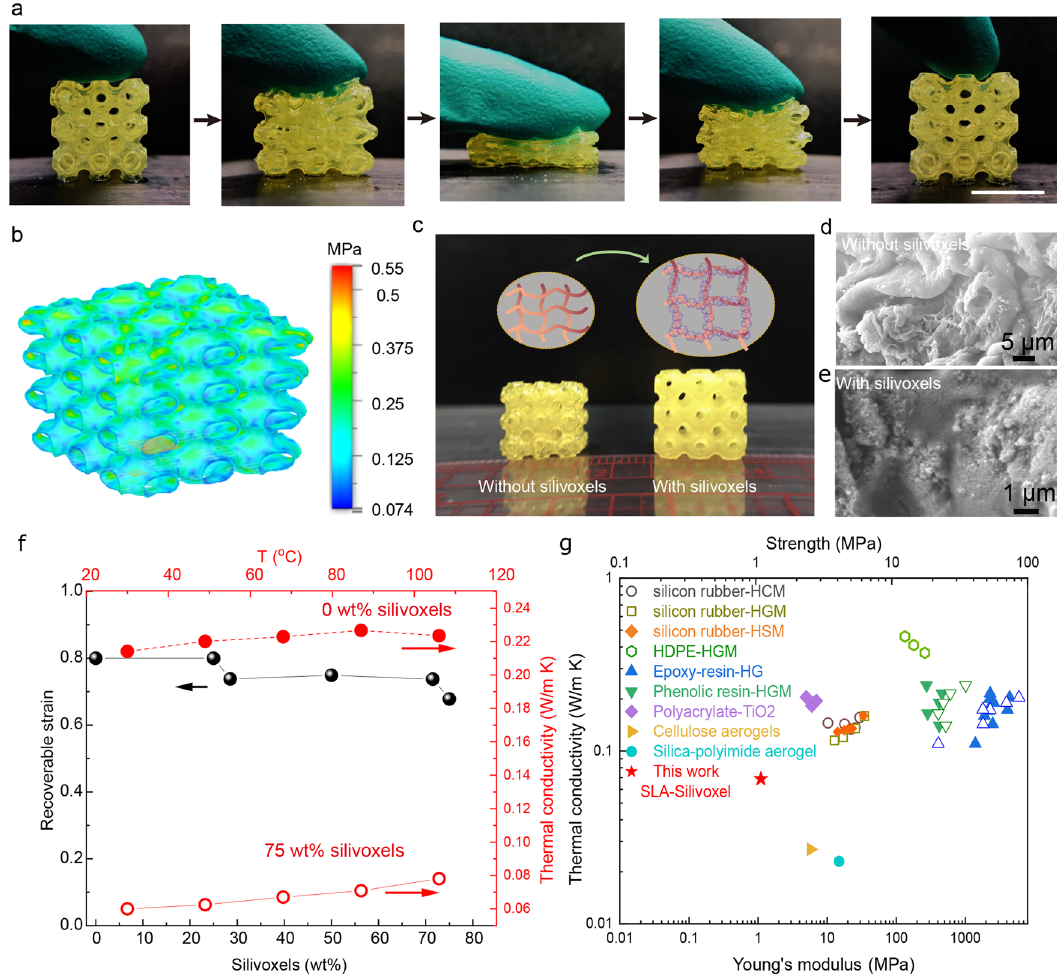
Fig. 2 | Characteristics of SLA-silivoxels. a The compressive recoverable SLA- silivoxels lattice with 70wt% silivoxel concentration. Scale bar is 10mm. b FEA (Finite element analysis) stress contour of uniaxial compression of SLA-silivoxels. c The optical images of dried SLA samples with and without silivoxels. The SLA- silivoxels can maintain the shape while SLA samples without silivoxels shrink sig- ni fi cantly. d SEM image of SLA sample without silivoxels. e SEM image of